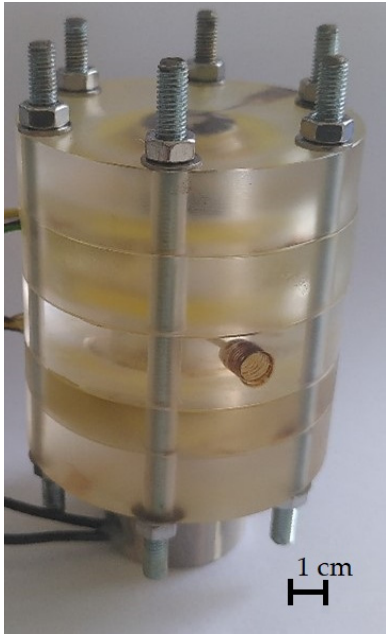
Figure 12. Assembled decanter consisting of a total of 5 acrylic glass modules.